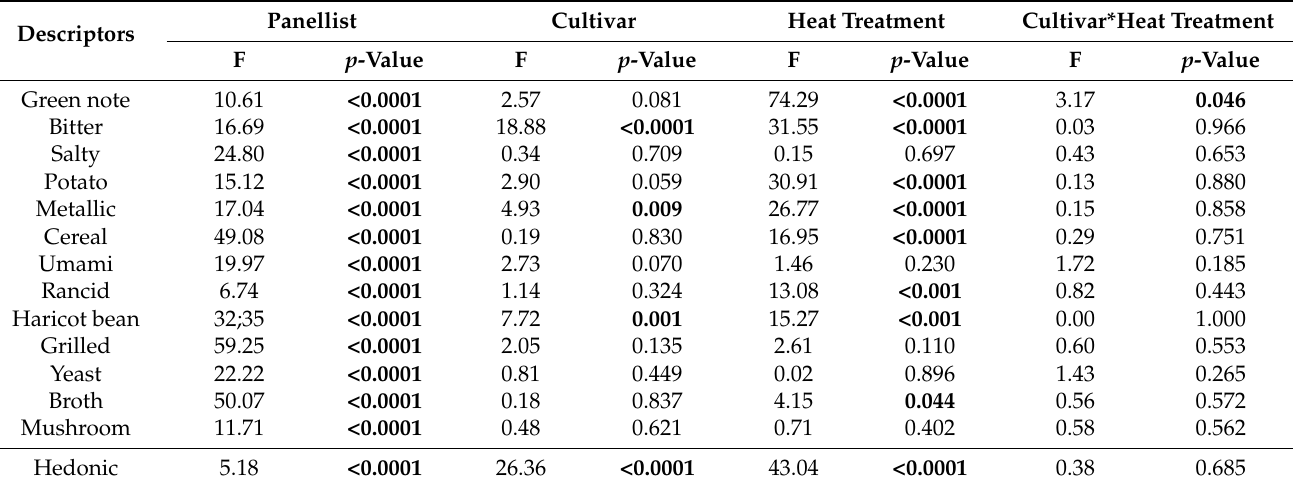
Table 5. Results of ANOVA (panellist + cultivar + heat treatment + cultivar*heat treatment) to examine the taste/aroma descriptor intensities and liking score of 6 gels (C1, C2, C3, H1, H2 and H3) (Table 1). Significant p -values are in bold ( α = 0.05).